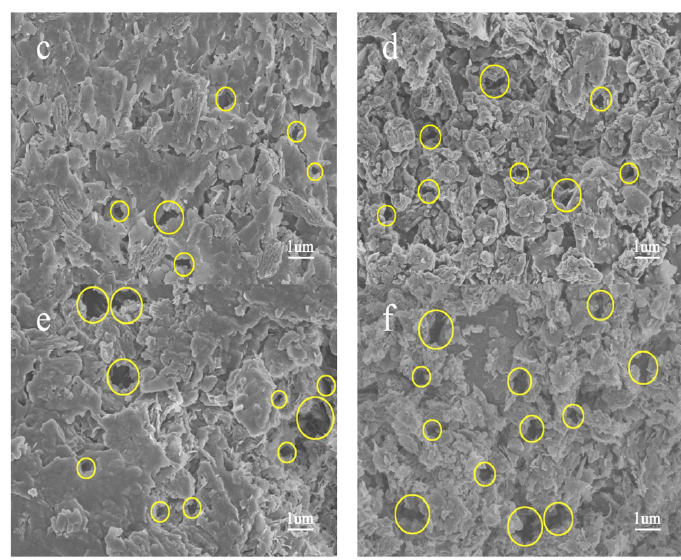
Figure 3. SEM images of ( a ) raw sample and spent shale samples extracted by sub-critical water at